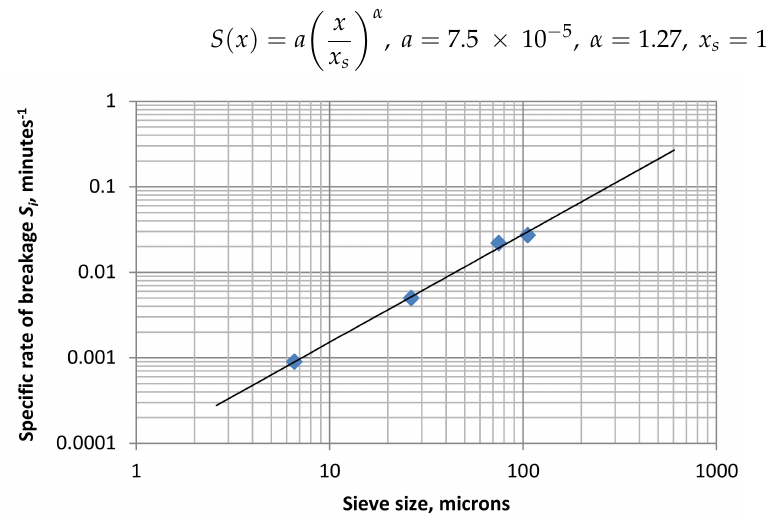
Figure 5. Variation of specific rate of breakage S i with particle size x i . The solid line is Equation (10) for the given